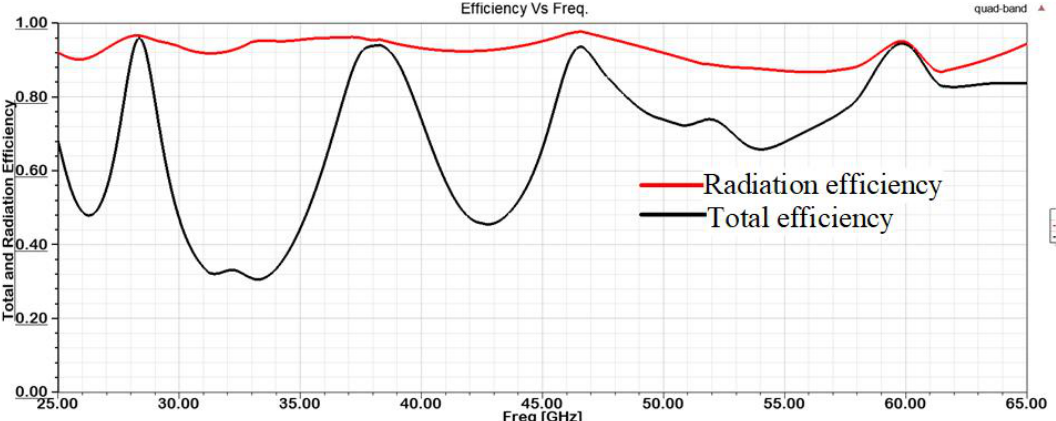
Figure 9. Total efficiency and radiation efficiency of the optimized antenna.